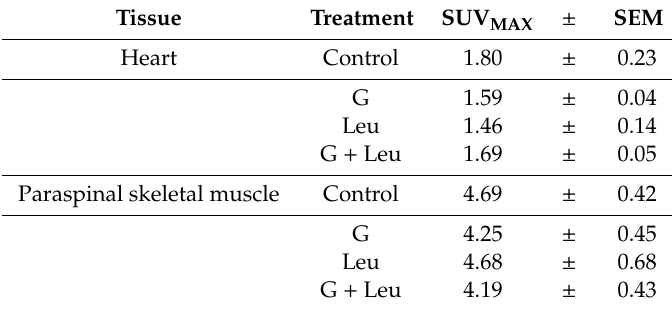
Table 1. Glucose uptake following glucose (G), leucine (Leu), or the combination of G + Leu in cardiac and skeletal muscle.